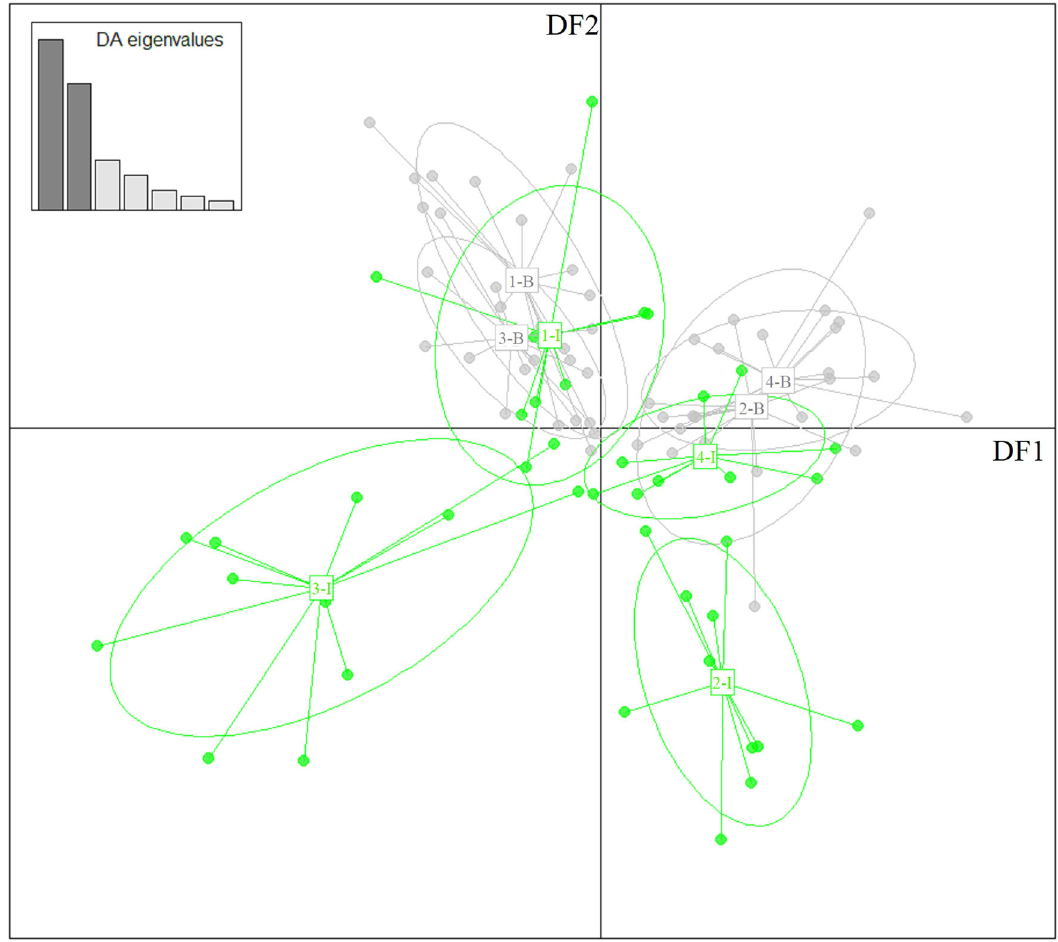
Fig. 4 Genomic variation between sites. Scatter plot of scores from Discriminant Analysis of Principal Components analysis of the genomic data. Population labels indicate the locality and beach (B) or inland (I). The fi rst discriminant function, DF1, represents 40.1% of the variation, while DF2 represents 29.9%. The inset plot (DA eigenvalues) shows the relative decline in variance explained by successive Discriminant functions from 1 to 7. Sample sizes are given in Supplementary Table